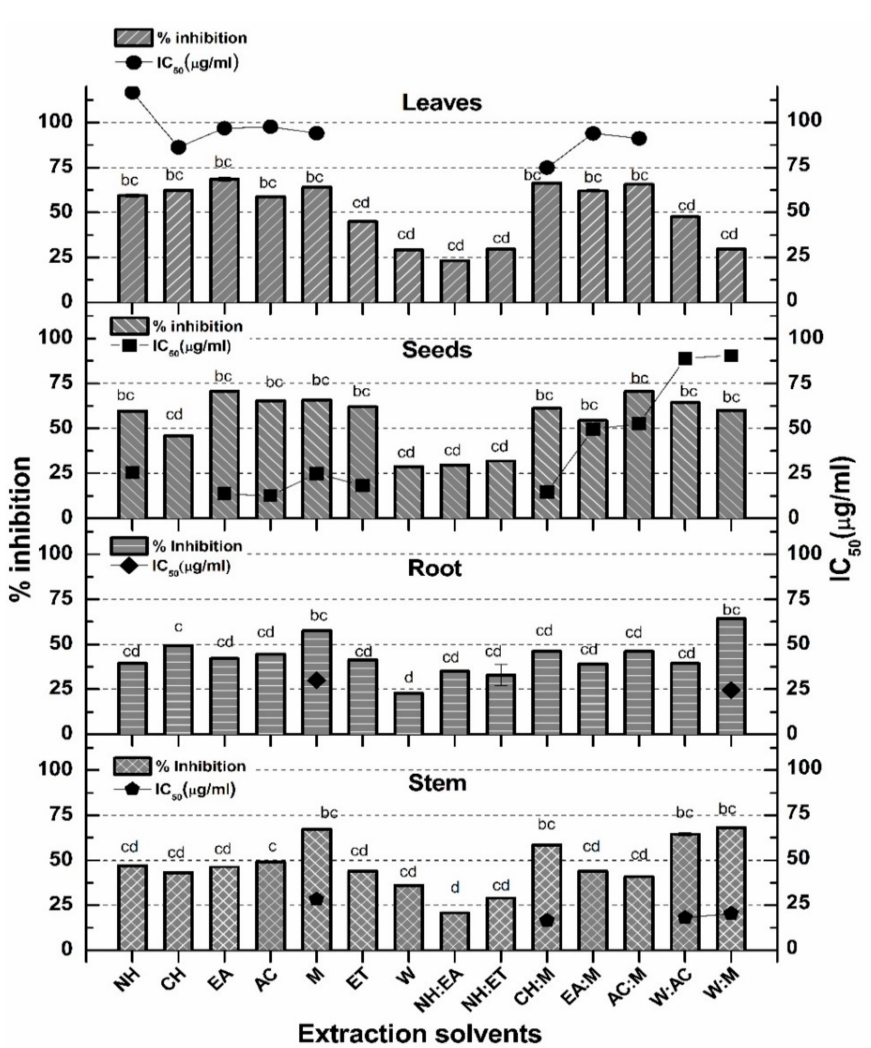
Figure 5. α -amylase inhibition by various solvent extracts of stem, root, seeds, and leaves of P. glabrum . The IC 50 of acarbose (positive control) was 33.73 ± 0.12 µ g/mL. The experiment was performed in triplicate, and values are presented as mean ± standard deviation. a − d means the difference is highly significant, slightly significant, and significant at p <